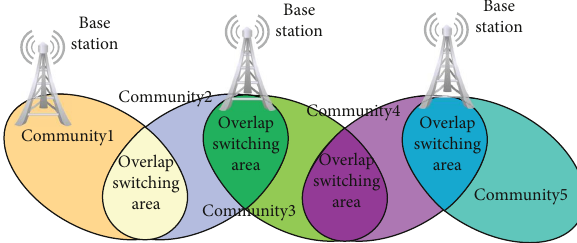
Figure 7: Schematic diagram of public network